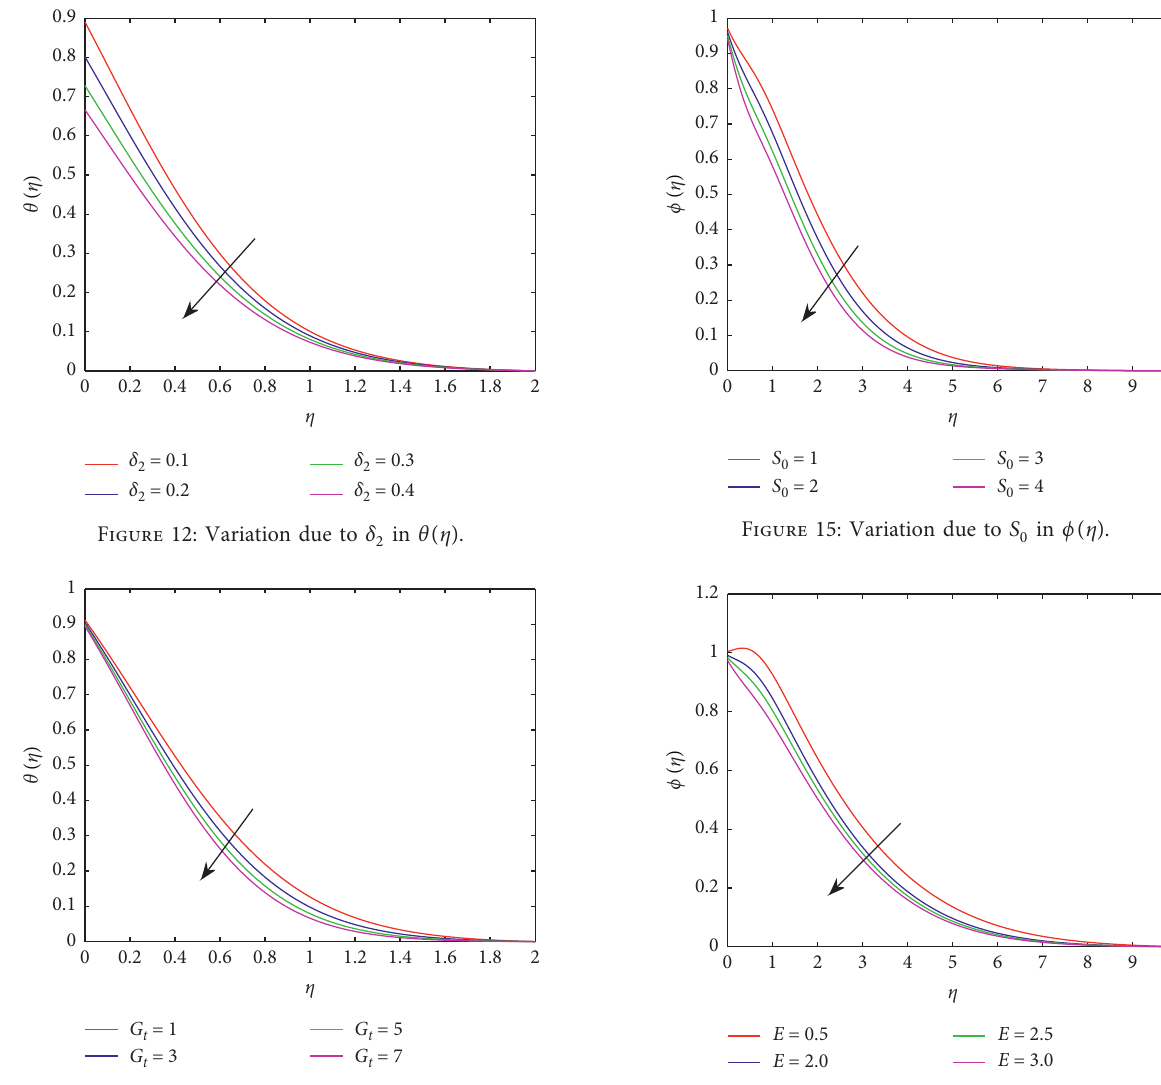
Figure 16: Variation due to E in ϕ ( η ) .